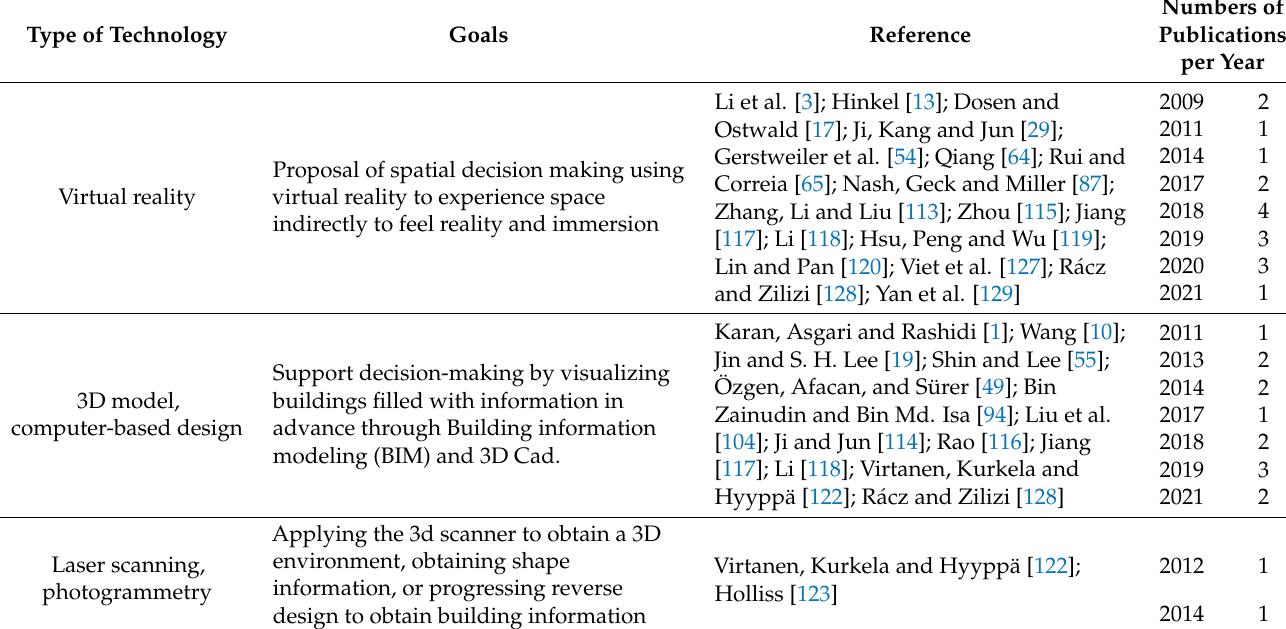
Table 5. Summary of technologies to support personalized space design